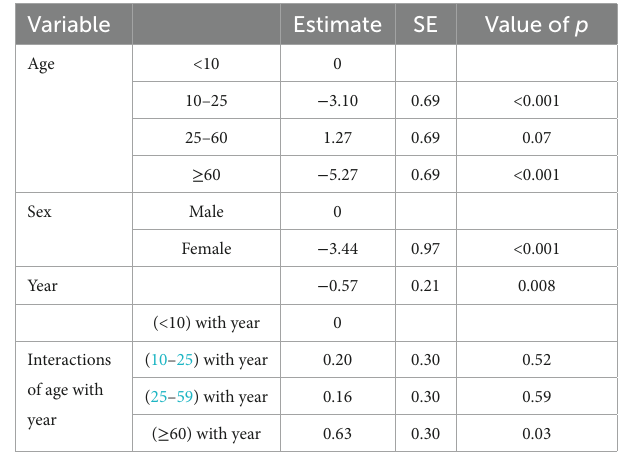
TABLE 3 Age and gender interactions of cutaneous leishmaniasis incidence trend in various provinces of Iran, 2013–2020.